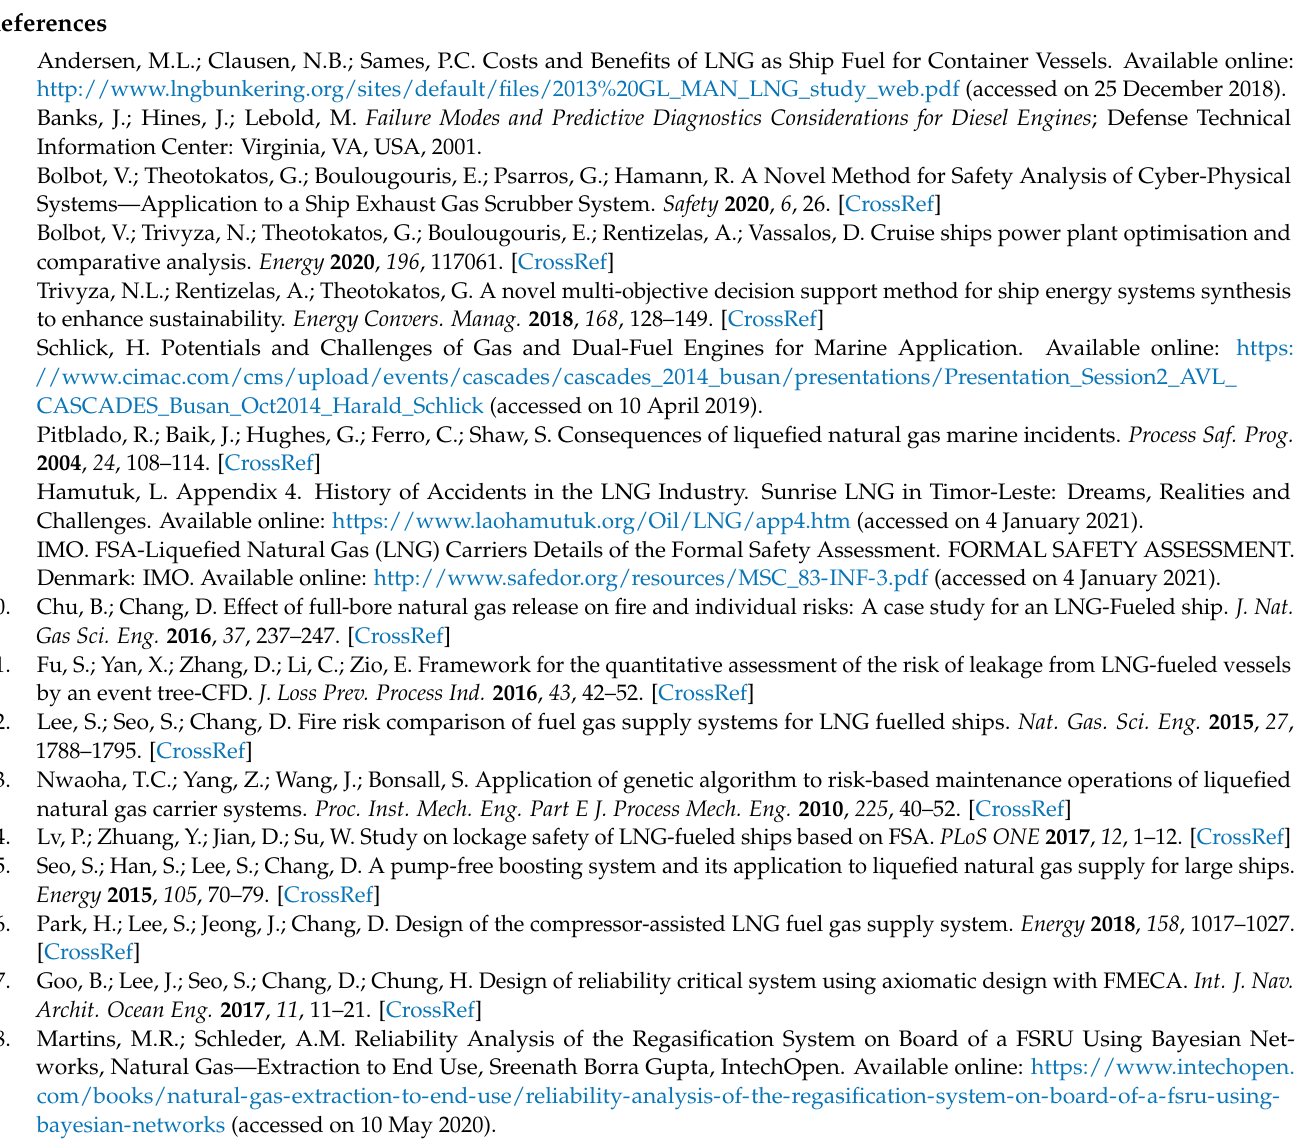
Figure A3. Fault tree for the top event of the disrupted natural gas flow developed in PTC Wind- chill.